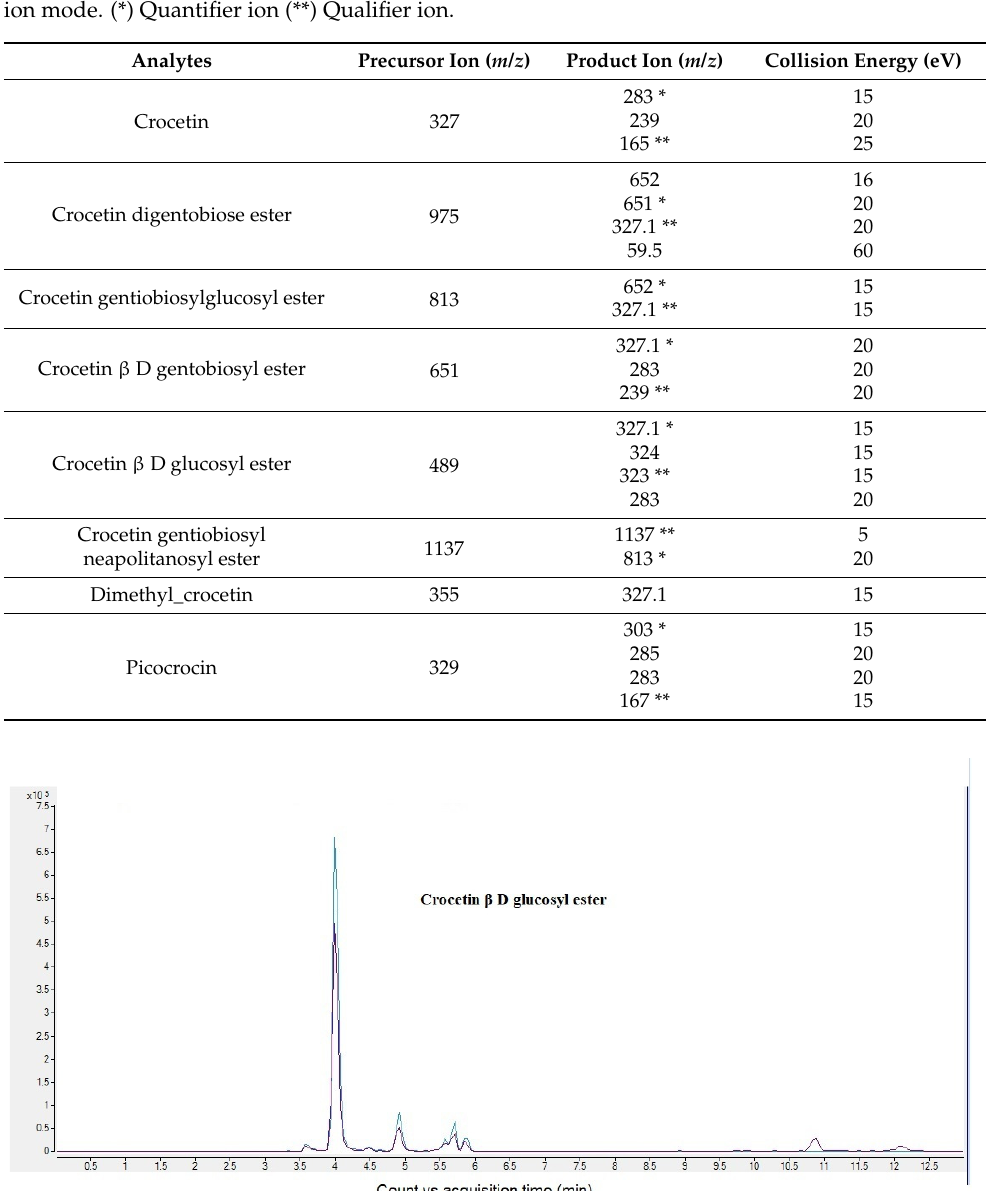
Figure 1. MRM chromatogram of Crocetin β D gentobiosyl ester (Crocin C). It is possible to appreciate different retention times relative to different isomers.